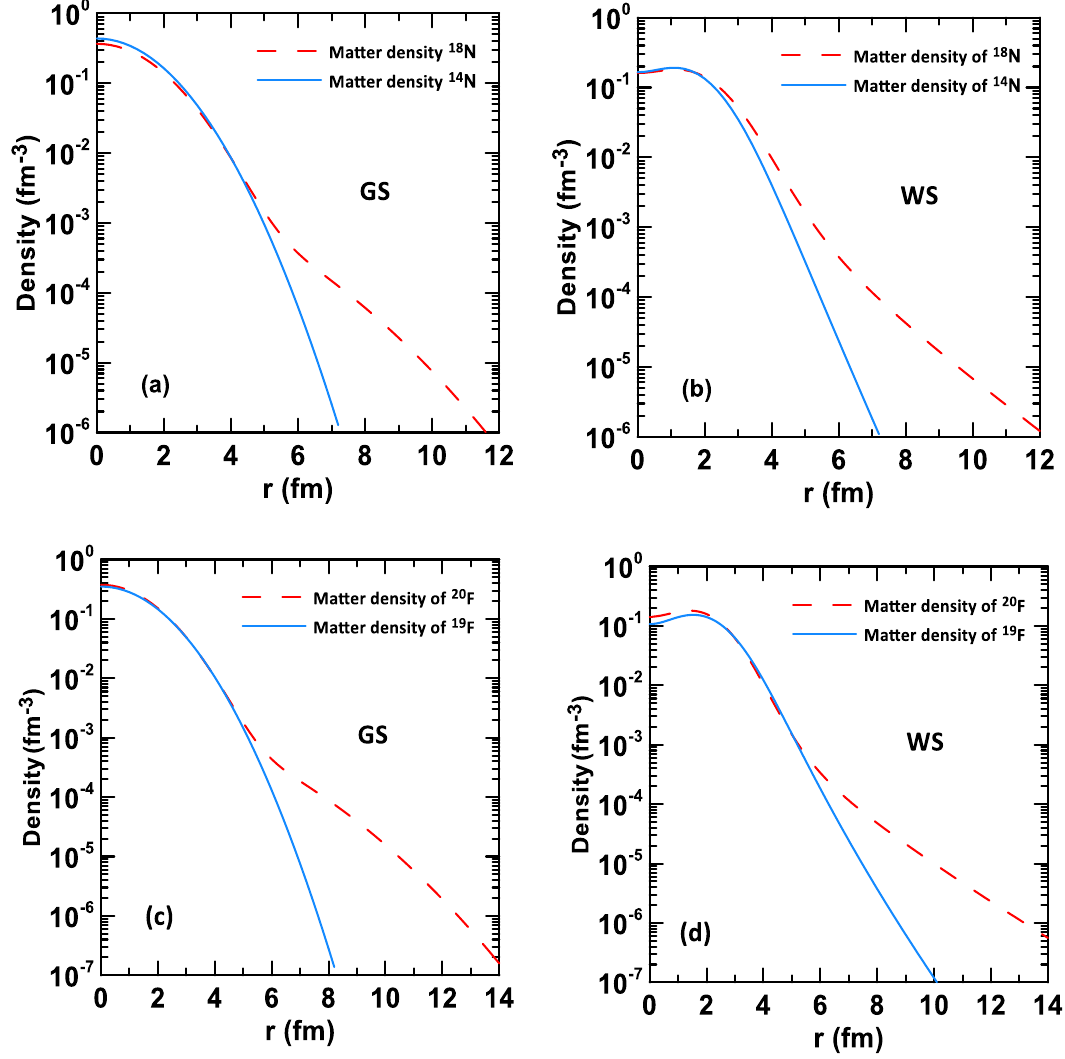
Figure 3: The distributions for 14,18 N and 19,20 F